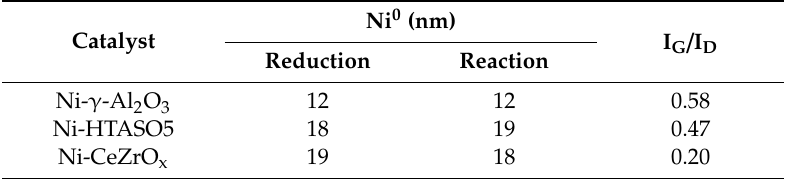
Table 2. Crystal size of nickel on Ni ‐γ‐ Al 2 O 3 , Ni ‐ HTASO5 and Ni ‐ CeZrO x after reduction and reaction as determined by XRD. The intensity ratio of G bond to D bond of deposited carbon after reaction at 600 °C for 9 h, tested by Raman spectroscopy.